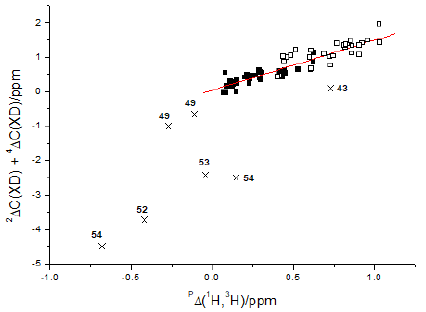
Figure 4. One-bond 18 O isotope effects on 13 C chemical shifts of averufin. The isotope effects are: C1 11ppb, C8 10 ppb and C9 29 ppb. Taken from Ref. [20]. Averufin is isolated for Aspergillus versicolor and it displays antibiotic properties.